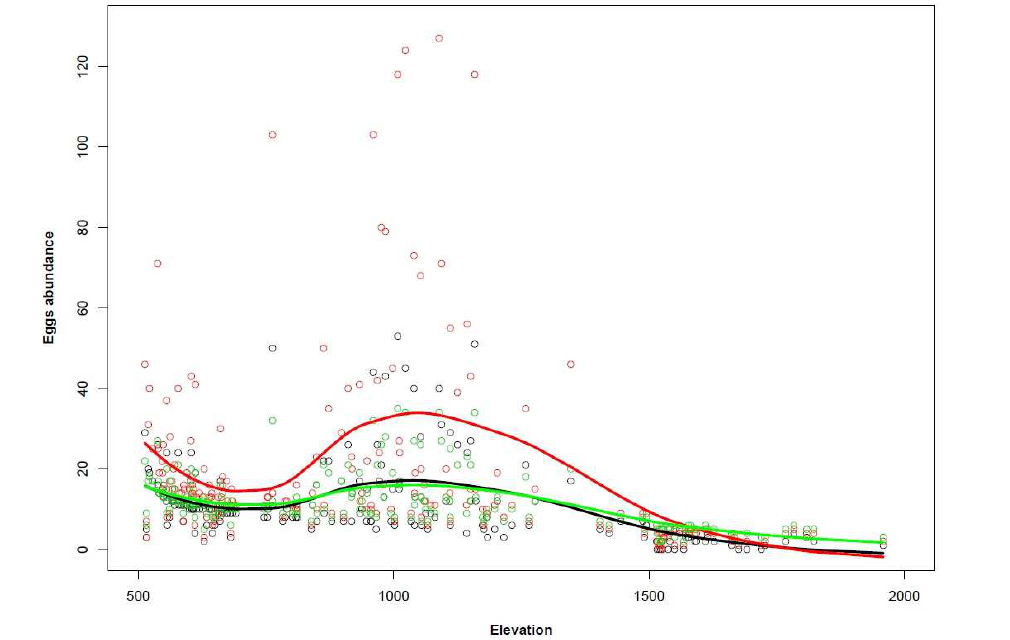
Figure 7. Scatter plot with three trend lines ( loess ) showing egg abundance distributions in relation to elevation for the three scenarios. The black line represents the initial potential distribution, the red line the climate warming scenario (+1.5 °C) and the green line the climate warming scenario combined with management action (50% reduction in Pelargonium plants). Extreme values ( n = 250) were omitted to improve the graphical representation.